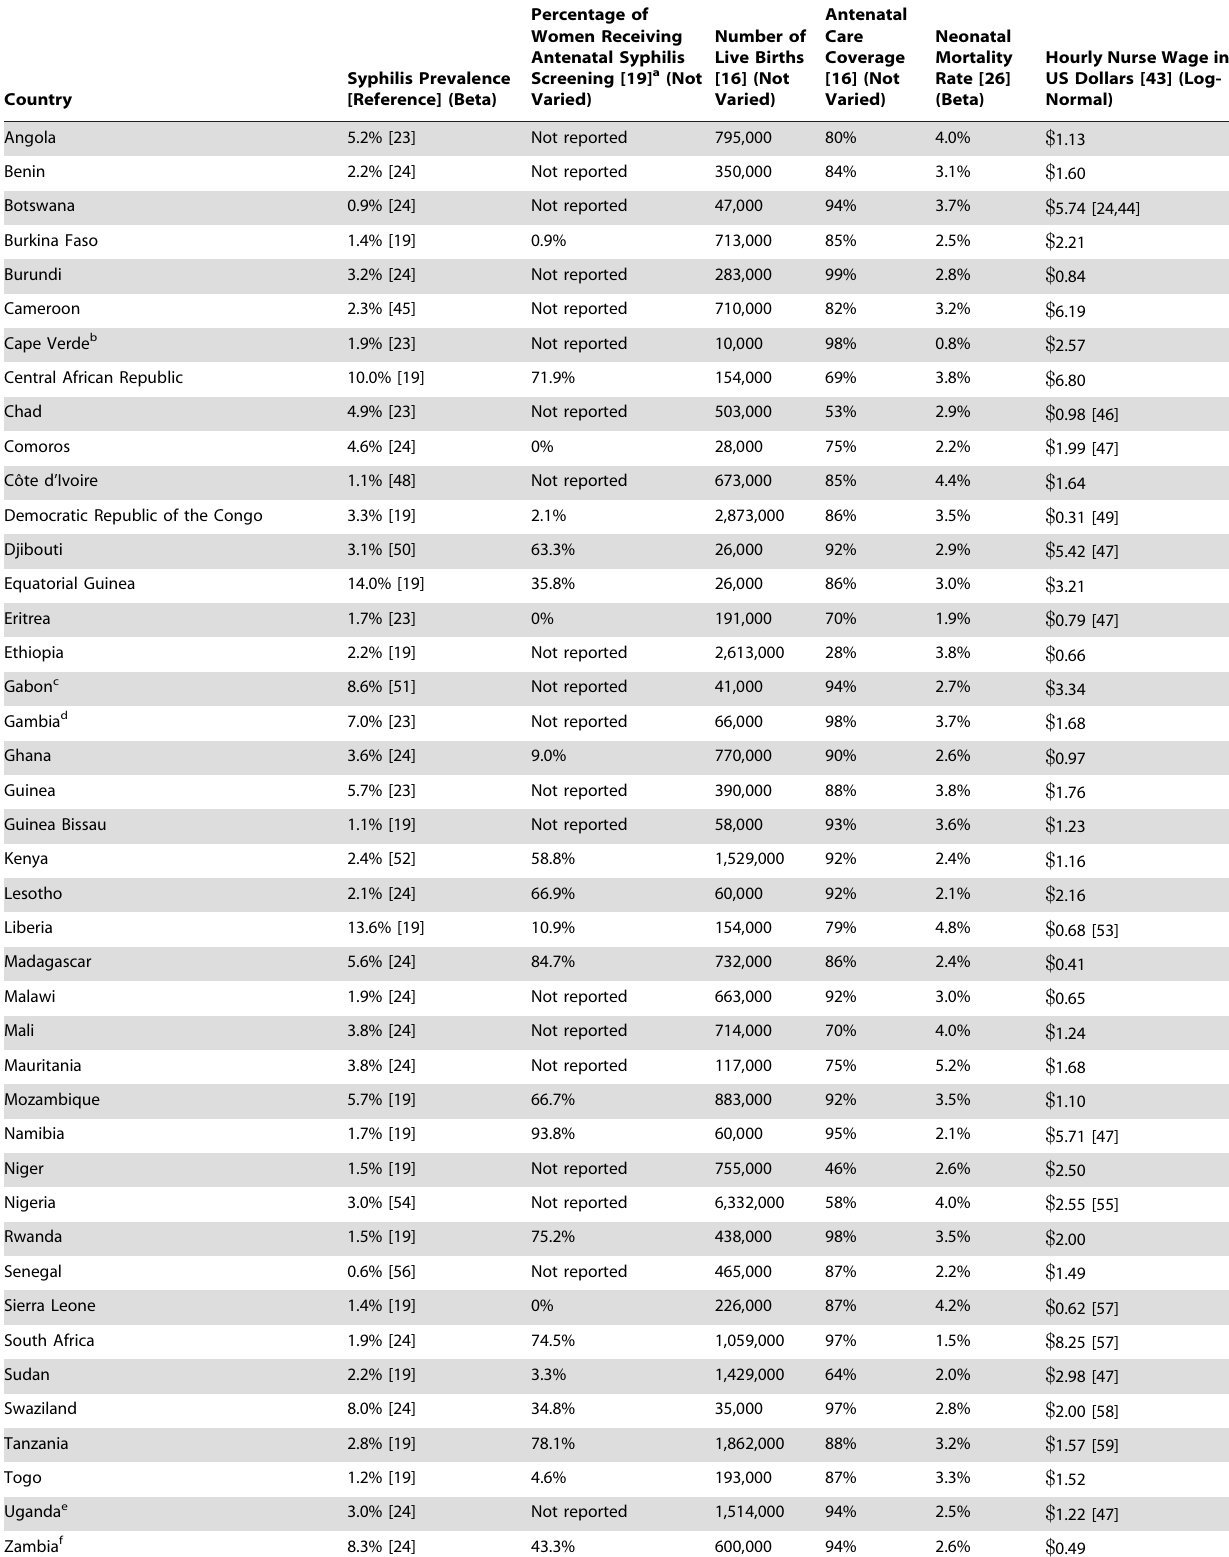
Table 2. Country-specific model inputs.